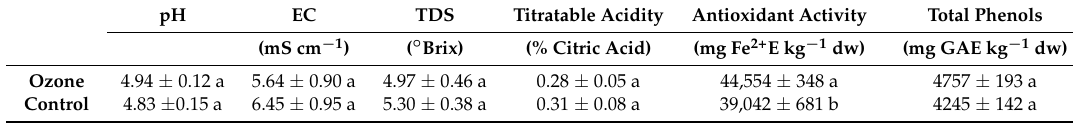
Table 1. Effect of ozone treatment on some qualitative traits in Radicchio rosso di Treviso